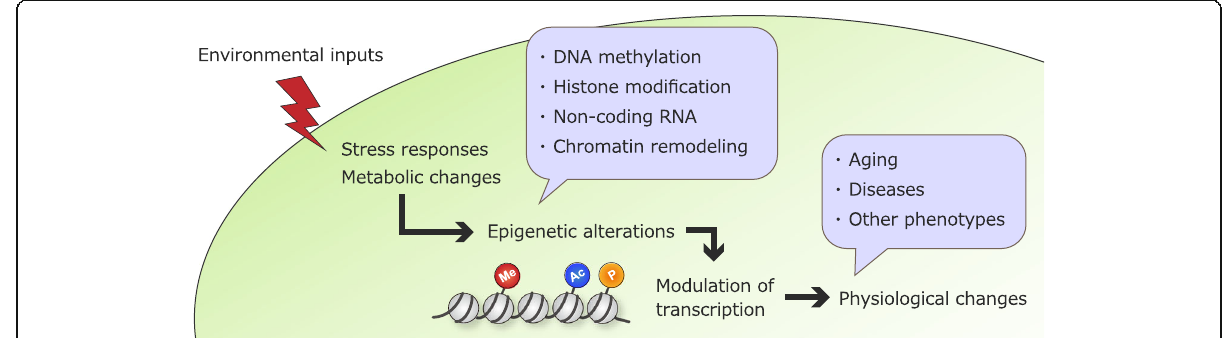
Fig. 2 A possible model of epigenetic regulation in response to environmental factors. The white area represents environmental circumstances, and the green area represents the plausible responses of organisms to environmental stimuli. Epigenetic alterations (such as histone modification and chromatin remodeling) are known as the hallmarks of aging, and these changes are profoundly dictated by environmental stimuli [3, 4, 49]. Me, histone methylation; Ac, histone acetylation; P, histone phosphorylation